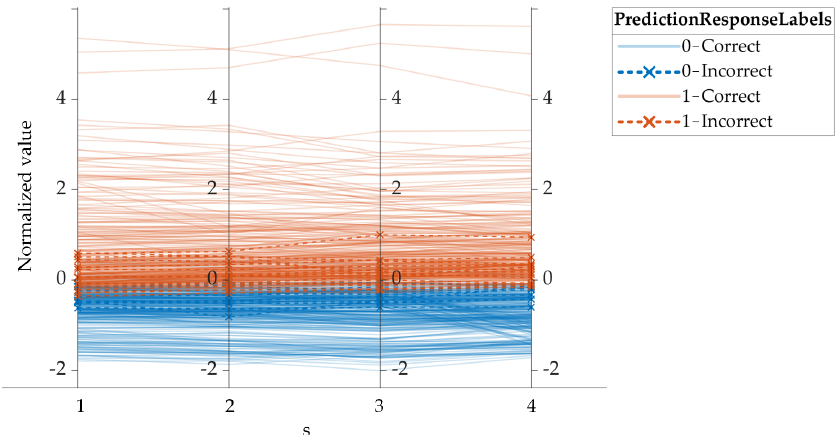
Figure 6. The parallel coordinates plot of the constructed SVM model.